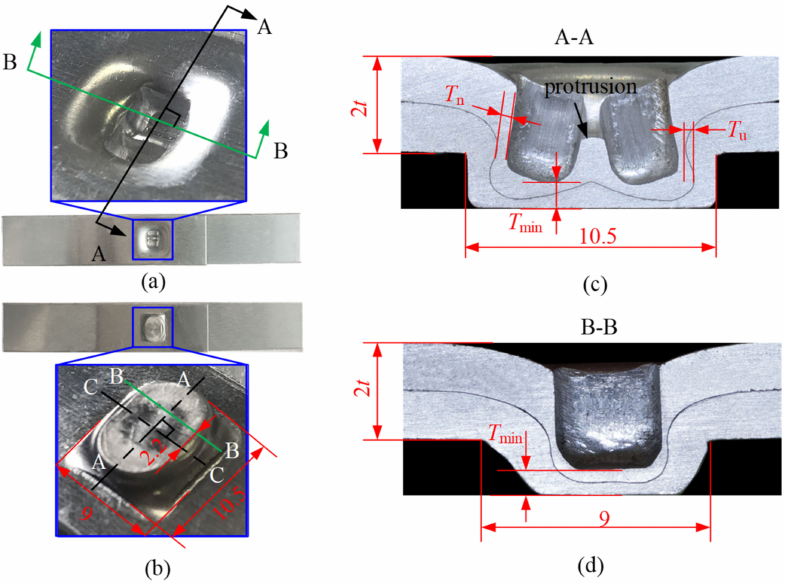
Figure 6. Images of the RCP joint (all dimensions in mm). ( a ) On the rotating punches side, ( b ) on the die side, ( c ) double- punch cross-section and ( d ) single-punch